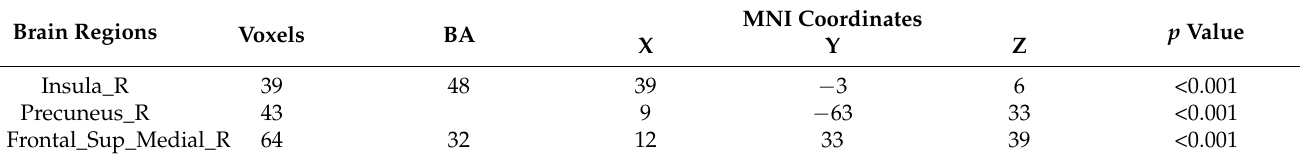
Table 2. Comparison of cerebral DC regions in ECMO survivors compared to